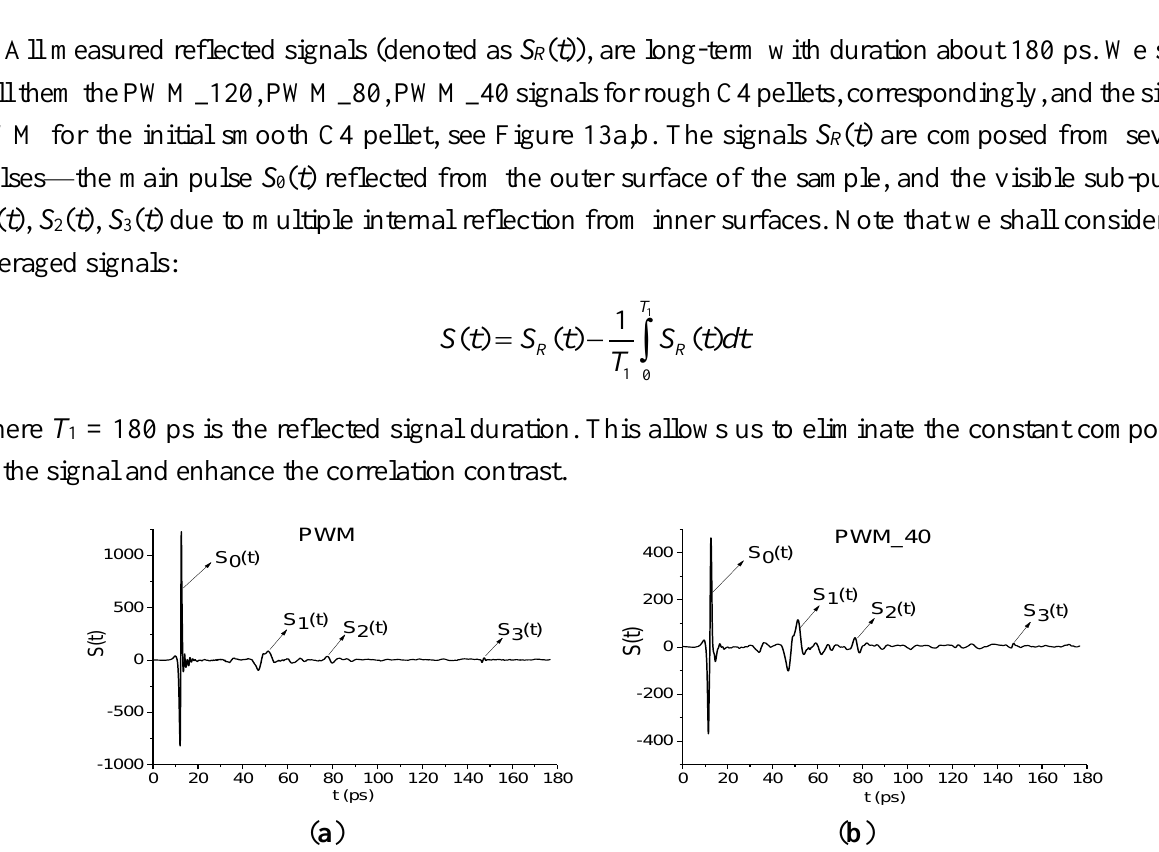
Figure 12. Surface treatment of the PWM C4 tablet [32].